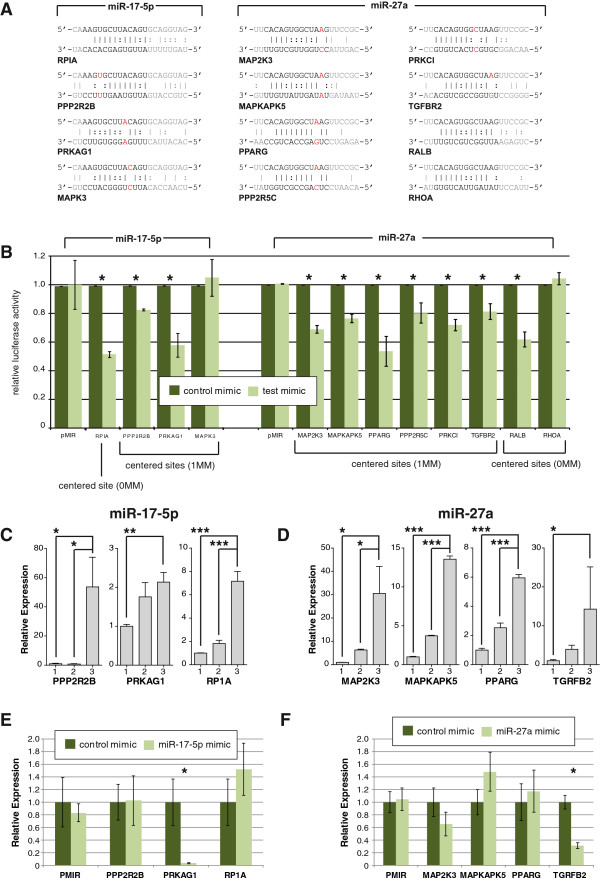
Centered sites can repress gene expression. (A) Four imperfect centered binding sites for miR-17-5p (left column) and eight for miR-27a (right columns) were tested via luciferase assay. Vertical line, perfect Watson-Crick matches; colon, GU wobble sites; shaded bases, regions outside of the central zone (nucleotides 3 to 15) that may participate in binding; red text, mismatches between the miRNA and its target in the central zone. Note that no other binding sites of any type were predicted within these mRNAs. (B) Mean luciferase activity relative to negative controls from the empty plasmid (pMIR) or pMIR containing one of the imperfect binding sites described above in the 3′ UTR. Asterisks indicate significant reduction in luciferase activity (one-sided t-test; P < 0.05), error bars represent standard error of the mean over three replicates. (C,D) A hybrid AGO2 immunoprecipitation/biotin pull-down was performed as in Figure 2F, and qRT-PCR was used to detect mRNAs confirmed to be targets of miR-17-5p (C) and miR-27a (D) above. Numbering on the x-axis refers to the samples described in Figure 2F. All targets were found to be significantly enriched in the AGO2-enriched fraction (*P ≤ 0.05, **P < 0.01, ***P < 0.001). (E,F) Analysis of luciferase expression levels by qRT-PCR found that only one out of three imperfect centered sites for miR17-5p (E) and one out of four sites for miR-27a (F) showed significantly reduced luciferase mRNA levels (P < 0.05, indicated by asterisks), indicating that most interactions that result in reduced protein are due to translational inhibition and not mRNA degradation.